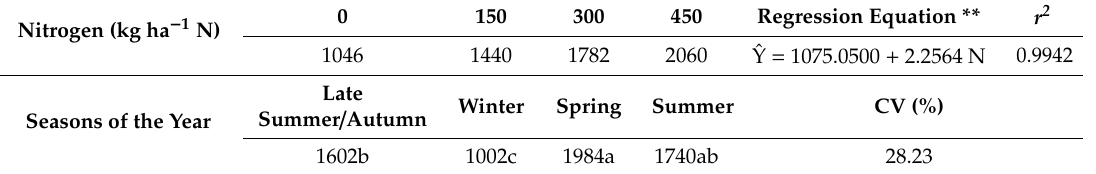
Table 9. Averages for post-grazing forage mass (kg DM ha − 1 ) of Brachiaria brizantha cv. Piat ã under rotational stocking and nitrogen fertilization throughout seasons of the year.